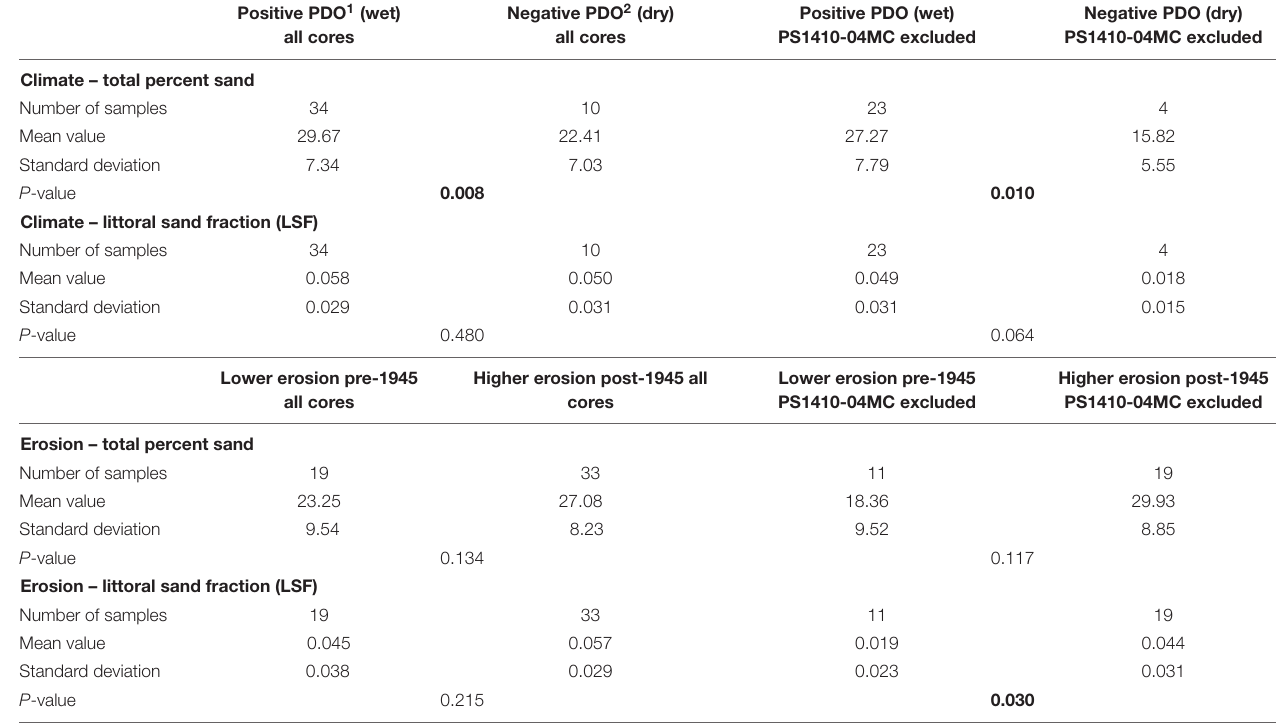
TABLE 2 | Comparison of sediment characteristics between different time